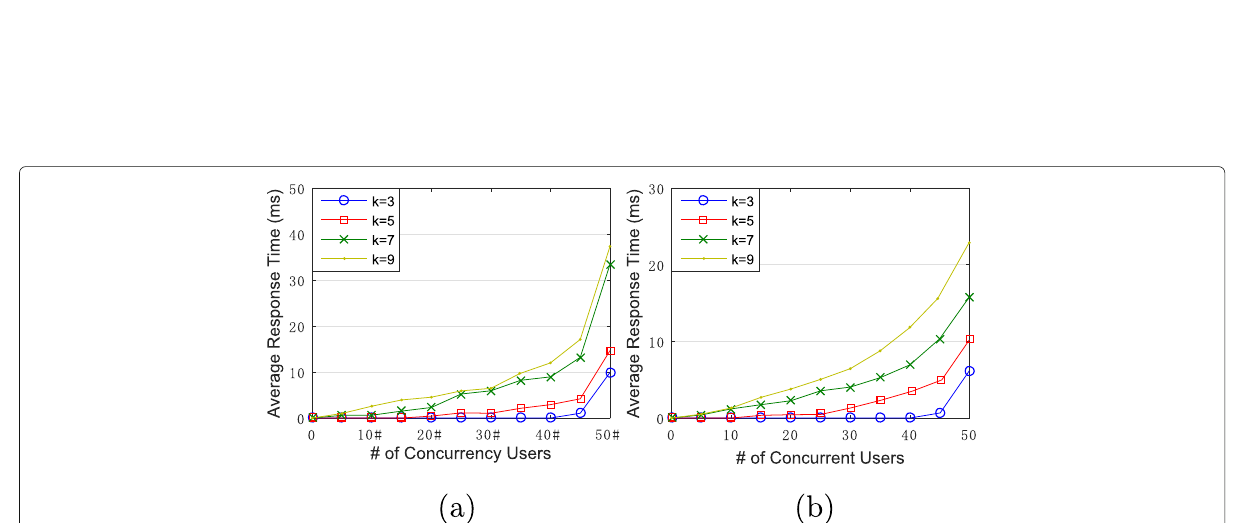
Fig. 10 The average response time of threat detection deployed on a dedicated server ( a ) and an AP frontend ( b